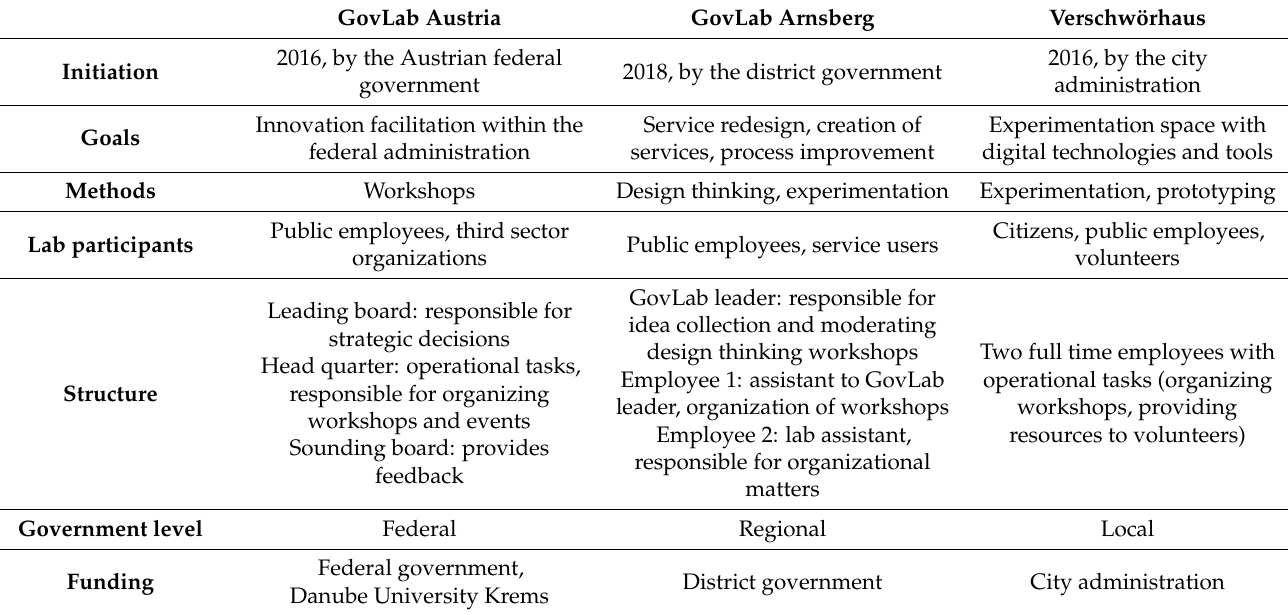
Table 2. Results from the embedded case